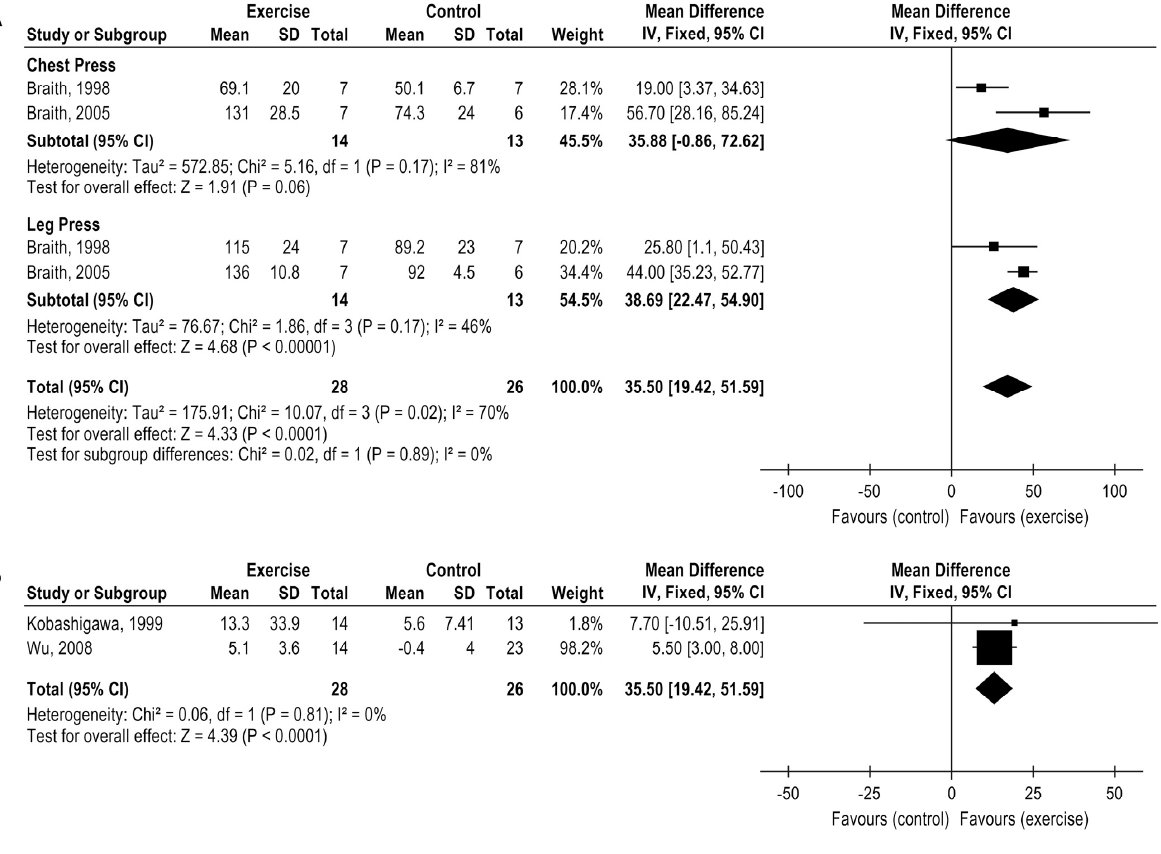
Figure 7. Impact of resistance training on muscle strength in HTx ( A ) 1 maximum repetition test ( B ) sit-to-stand test.